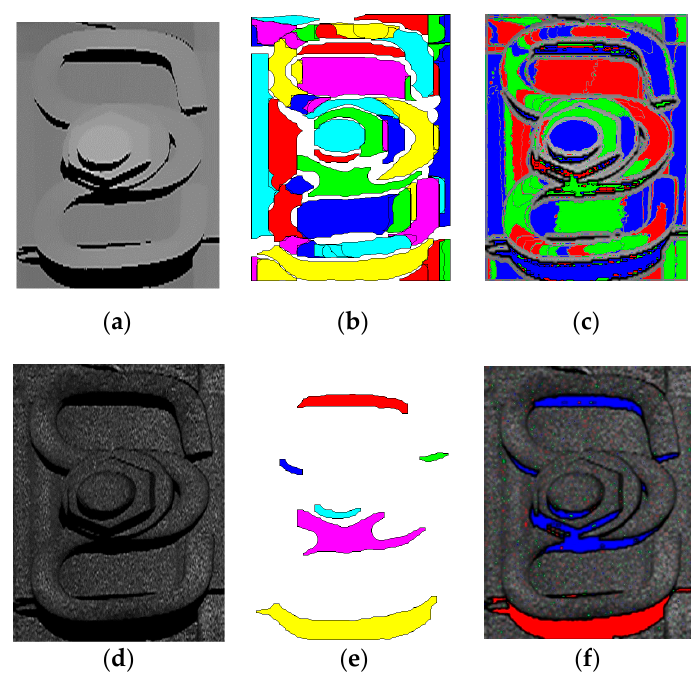
Figure 6. Segmentation results of fastener area in depth map and intensity map. ( a ) Depth map; ( b ) result of area growth method for ( a ); ( c ) result of watershed algorithm for ( a ); ( d ) intensity map; ( b ) result of area growth method for ( b ); ( f ) result of watershed algorithm for ( b ).